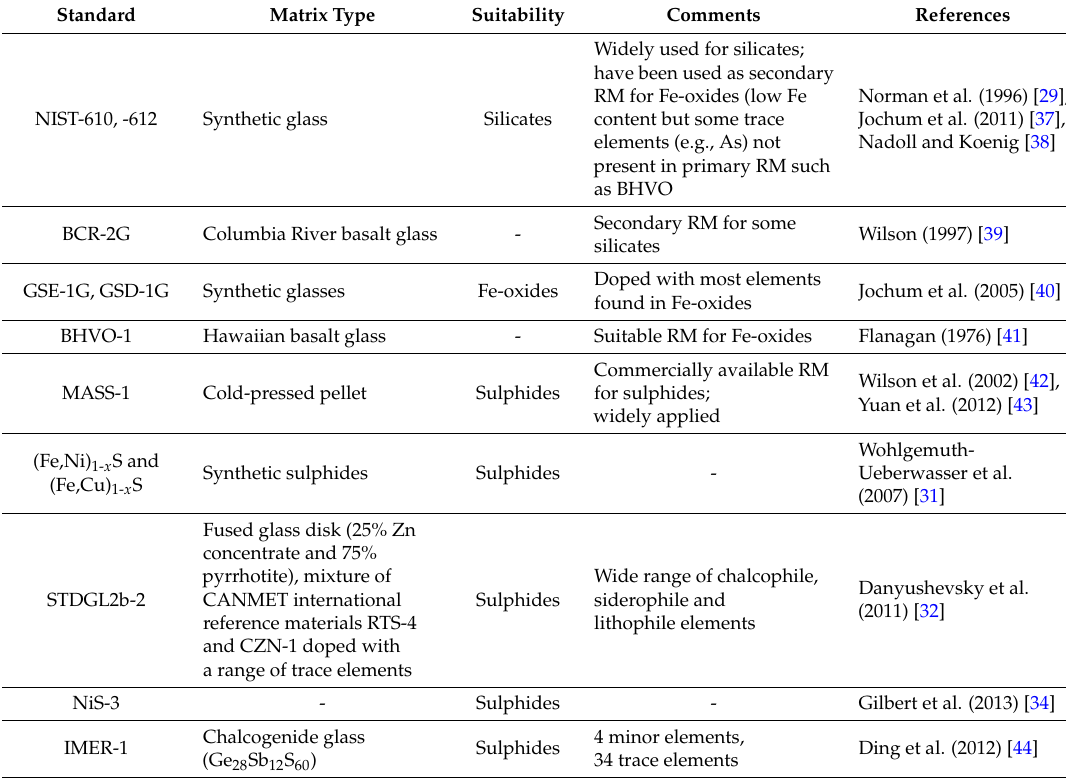
Table 1. Reference materials (RM) commonly employed for laser ablation inductively-coupled